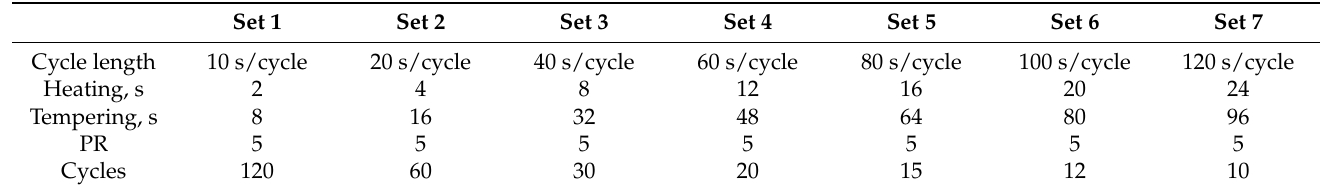
Table 2. The samples with different cycle lengths.